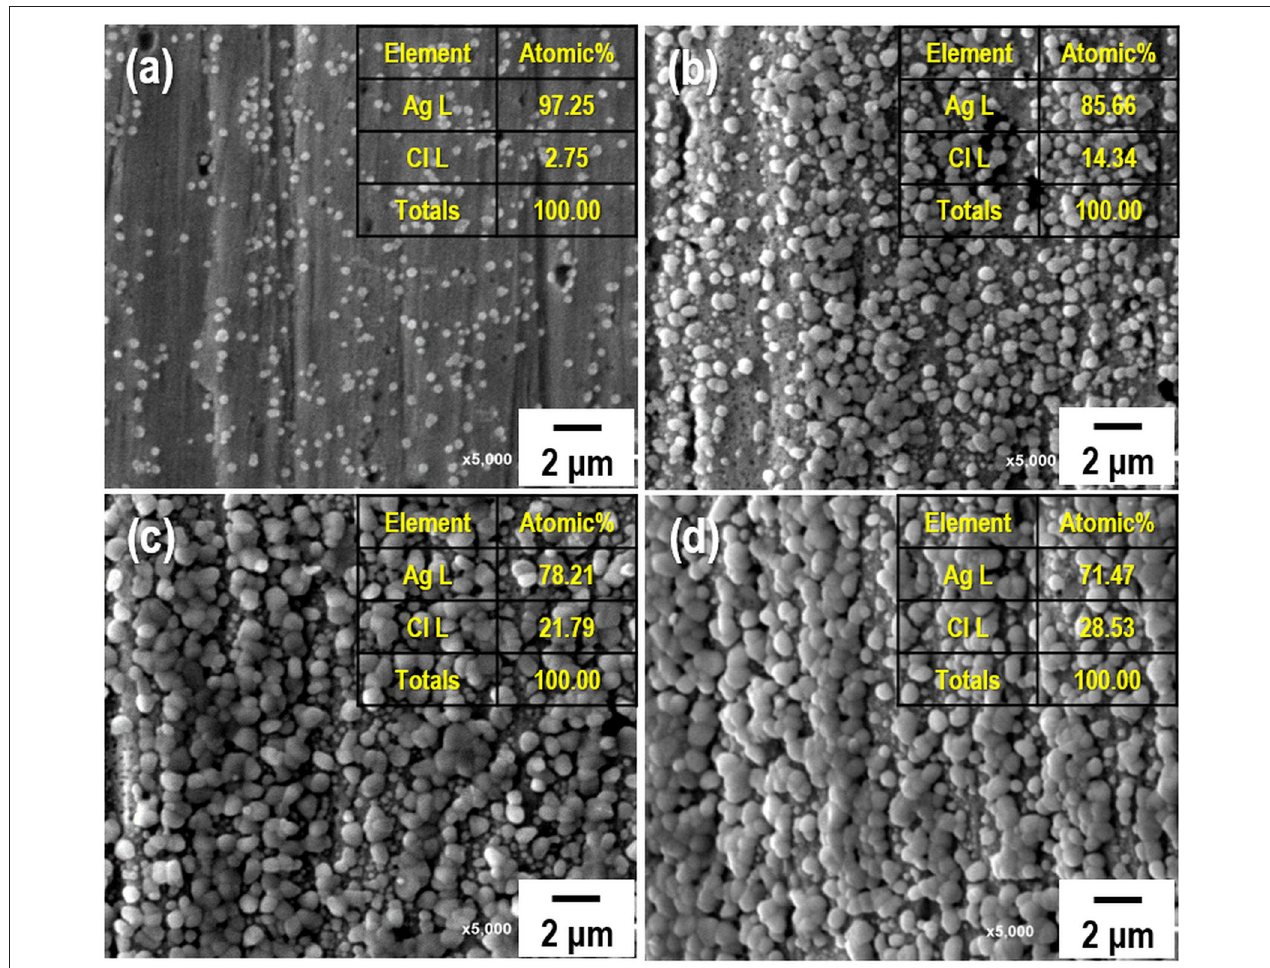
FIGURE 4 | Field-emission scanning electron microscopy (FE-SEM) images and elemental compositions of the AgCl-coated Ag wire with different immersion times: (a) 1s, (b) 60s, (c) 90s, and (d) 120s. The current density and treatment time for the galvanostatic polarization of all samples are fixed at 30 mA/cm 2 and 2h,